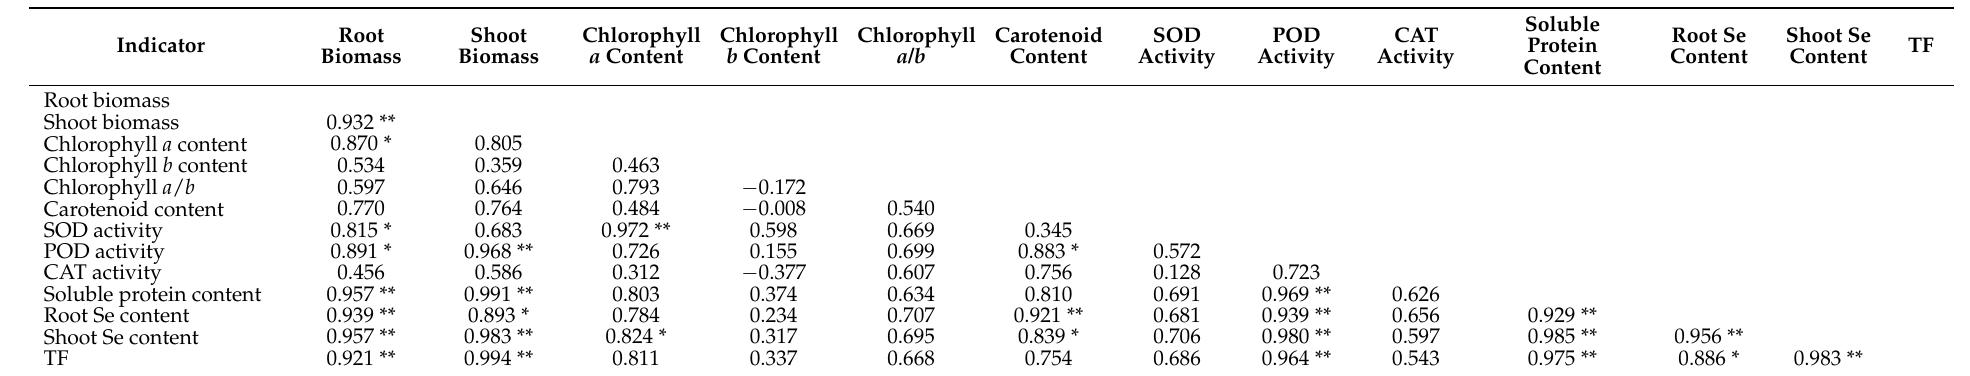
Table 6. Correlations among the different indicators of